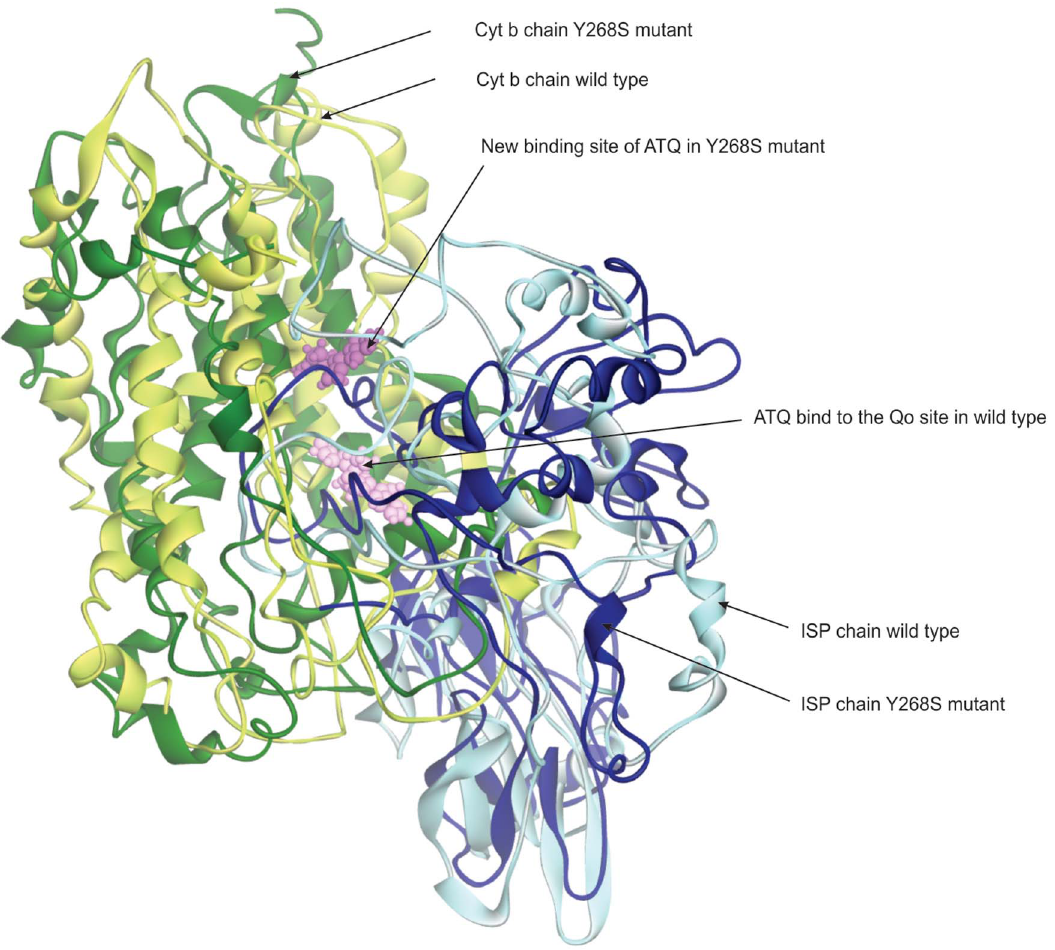
Figure 5. ATQ binding site in the wild and mutant (Y268S) Cyt bc1 complex of P.falciparum . The figure indicates that ATQ binds to a new site in the mutant model which is around 12 A˚ distant from the Qo site. The structure was captured from the average structure of the Cyt bc1 complex of P. falciparum over 70–90 ns (converged part of the trajectory).